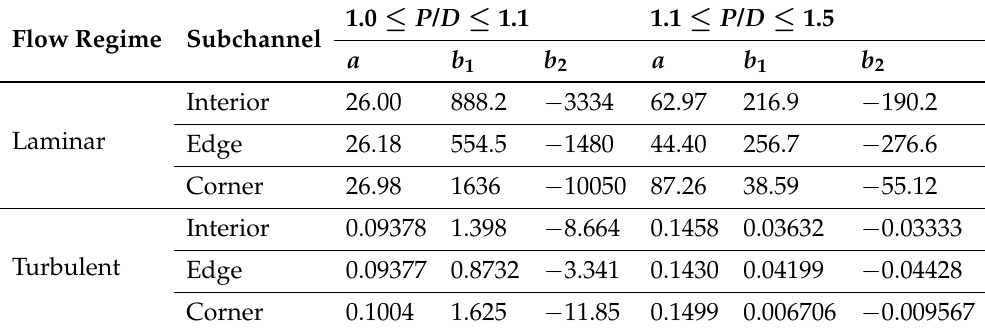
Table 1. Coefficients for bare rod subchannel friction factor constants in triangular